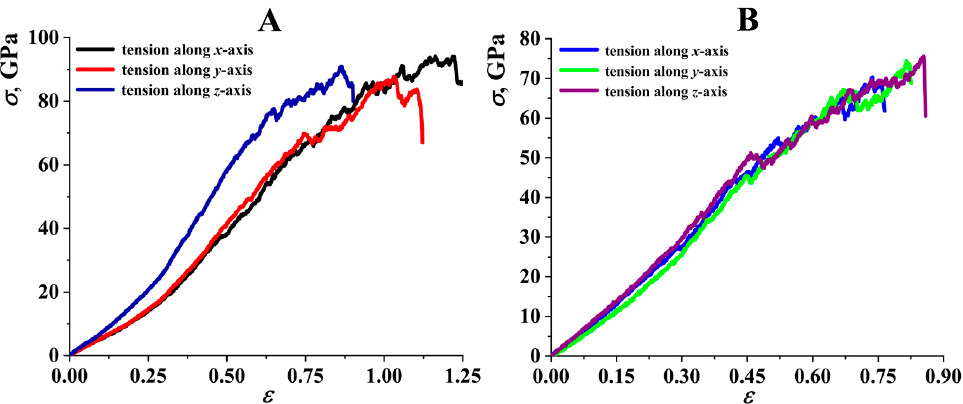
Figure 3. Uniaxial tensile stress–strain curves for graphene fibers with two morphologies ( A , B